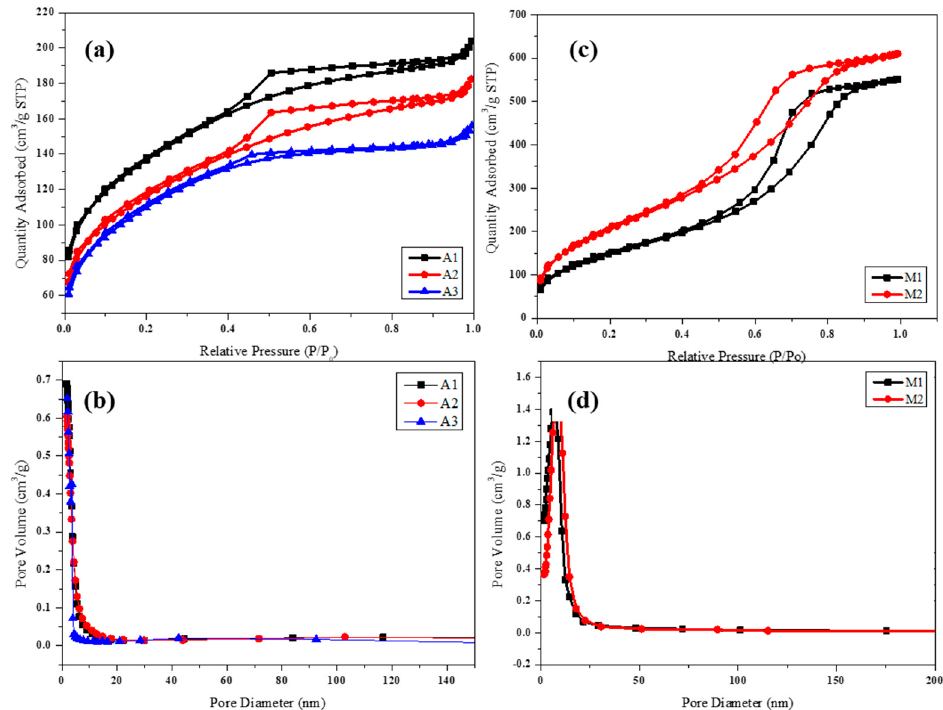
Figure 7. BET analysis of the series of MSPs. ( a ) The N 2 adsorption-desorption isotherm as well as ( b ) the pore size distribution curves for the hydrophilic MSPs (A1, A2 and A3). ( c ) The N 2 adsorption-desorption isotherm and ( d ) pore size distribution curves of the hydrophobic MSPs (M1 and M2).